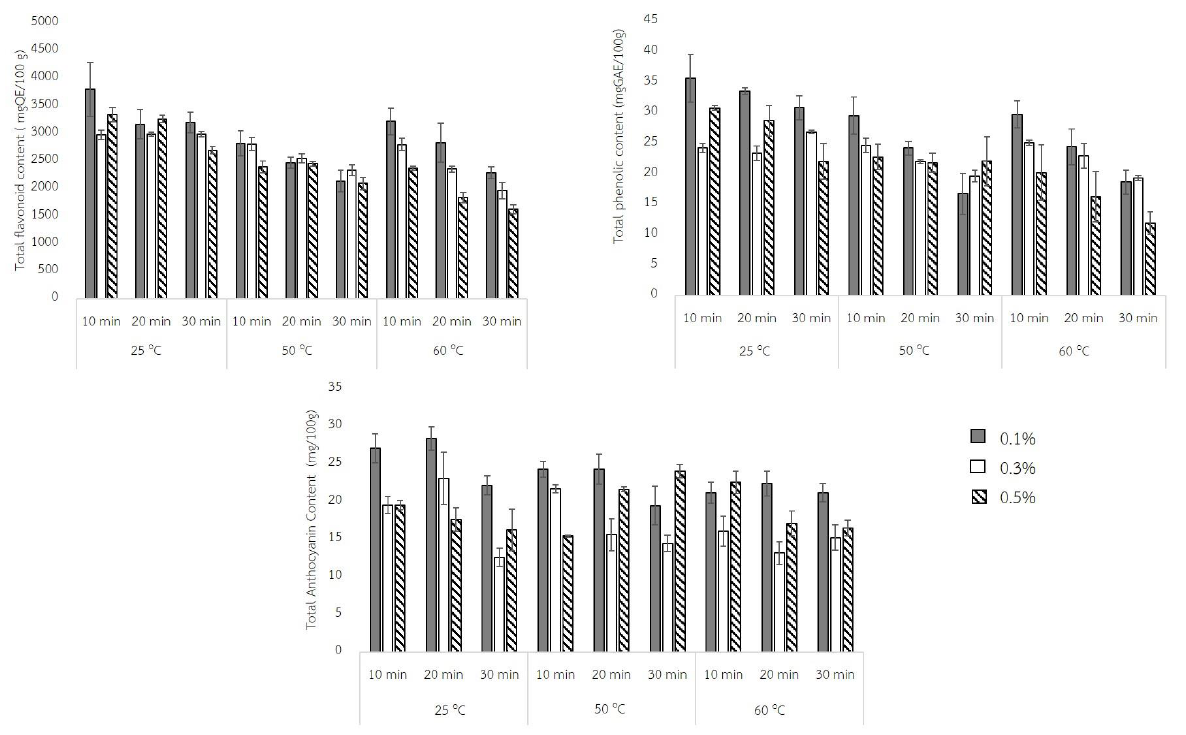
Figure 4. The total phenolic ( TPC ) , total flavonoid ( TFC ), as well as total anthocyanin ( TAC ) content of each QBJR sample .